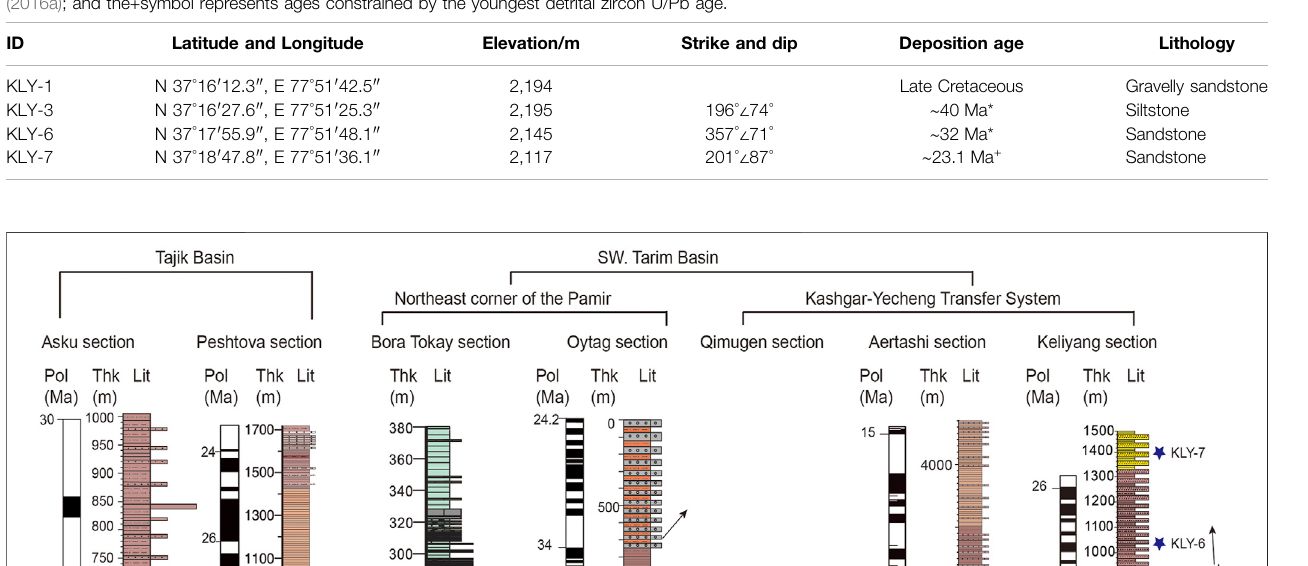
Frontiers in Earth Science |